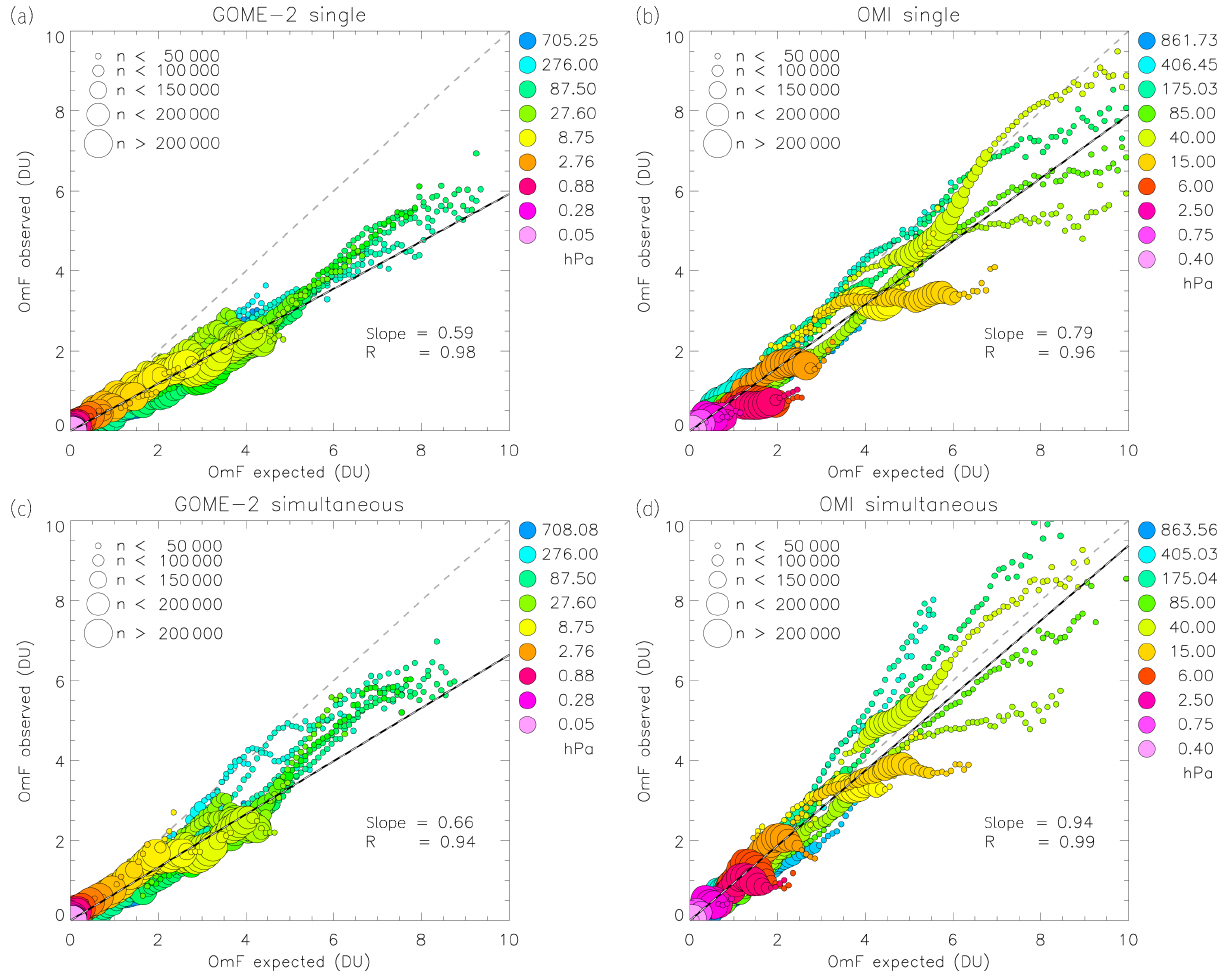
Figure 12. Observed vs. expected OmF. (a) Assimilation of GOME-2 only, (b) assimilation of OMI only. (c, d) Results from the simultaneous assimilation of both GOME-2 and OMI. (c) GOME-2, (d) OMI. Colours indicate the pressure levels. Note that not all levels are plotted in the legend while all levels are plotted in the figure. The size of the circles gives the number of assimilated pixels ( n ) in that respective OmF-bin (bin-size = 0 . 2DU). The slope for the fitted (dashed) line is given in the lower right corner of each panel, as is the correlation ( R ) between the expected and observed